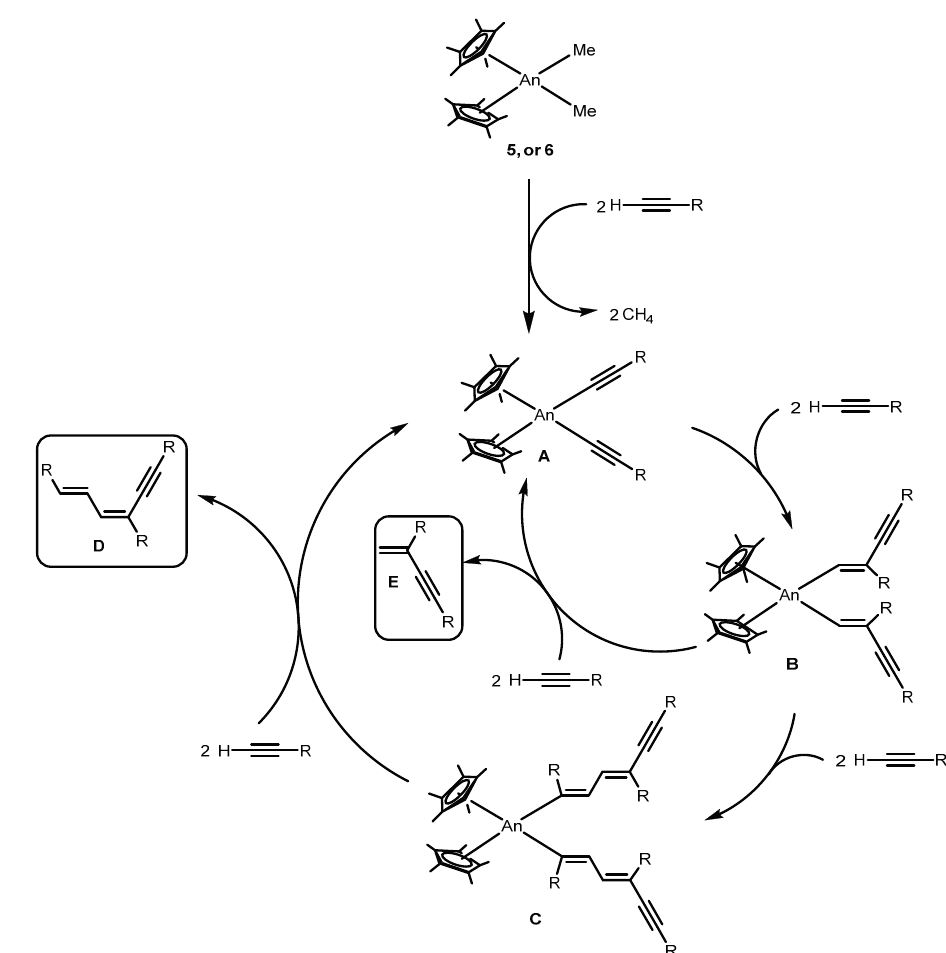
Scheme 10. Proposed mechanism for the actinide mediated oligomerization of terminal alkynes. Adapted with permission from Haskel, A.; Straub, T.; Dash, A.K.; Eisen,